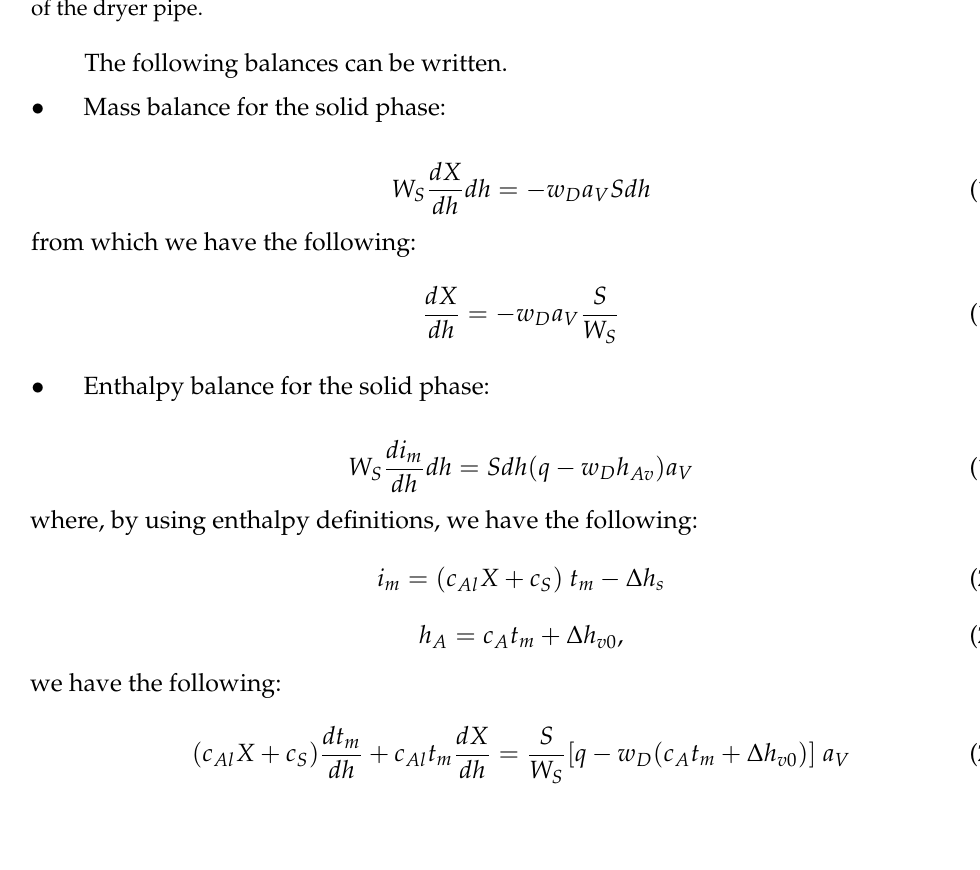
Figure 11. Schematic of the momentum, heat, and mass balances over a differential volume element of the dryer pipe. of the dryer